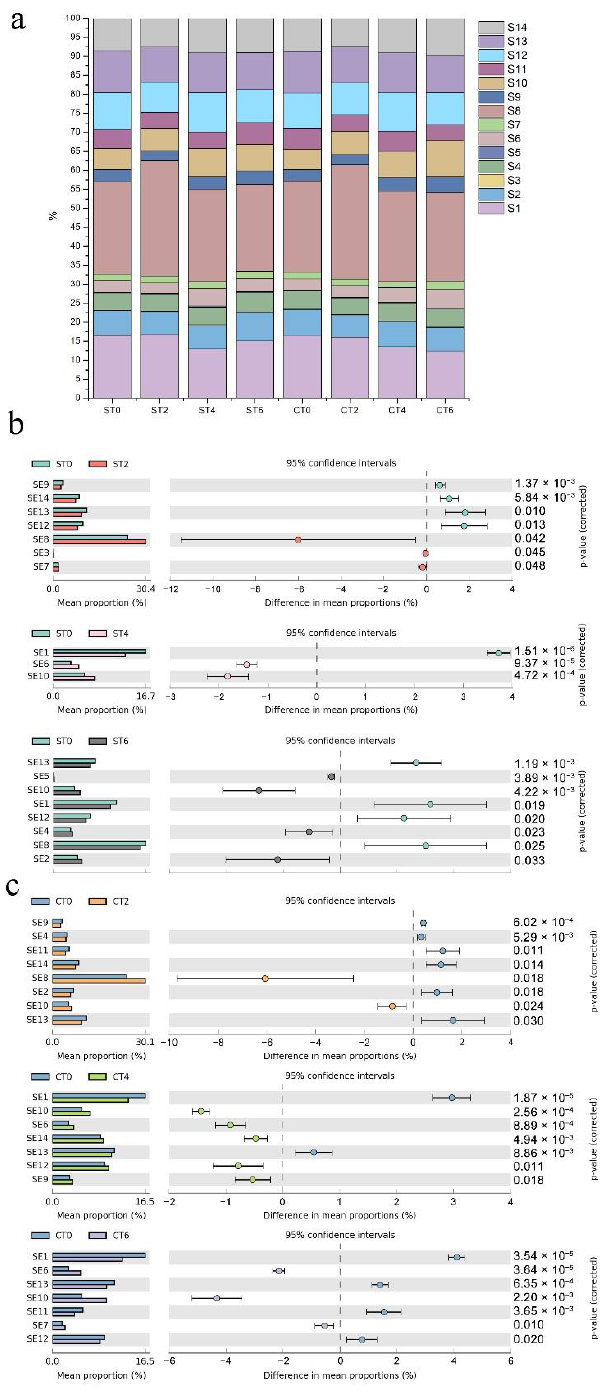
Figure 6. Histogram of the proportion of gas produced by intestinal microorganisms and the differ- ence between groups. ( a ) Bar chart of gas composition; ( b ) differences between groups of aqueous extract; ( c ) differences between groups of alcohol extract (0—no sample added; 2, 4, 6 denote fer- mentation days after sample addition). (S1—ammonia and amines; S2—hydrogen sulfide, sulfide;